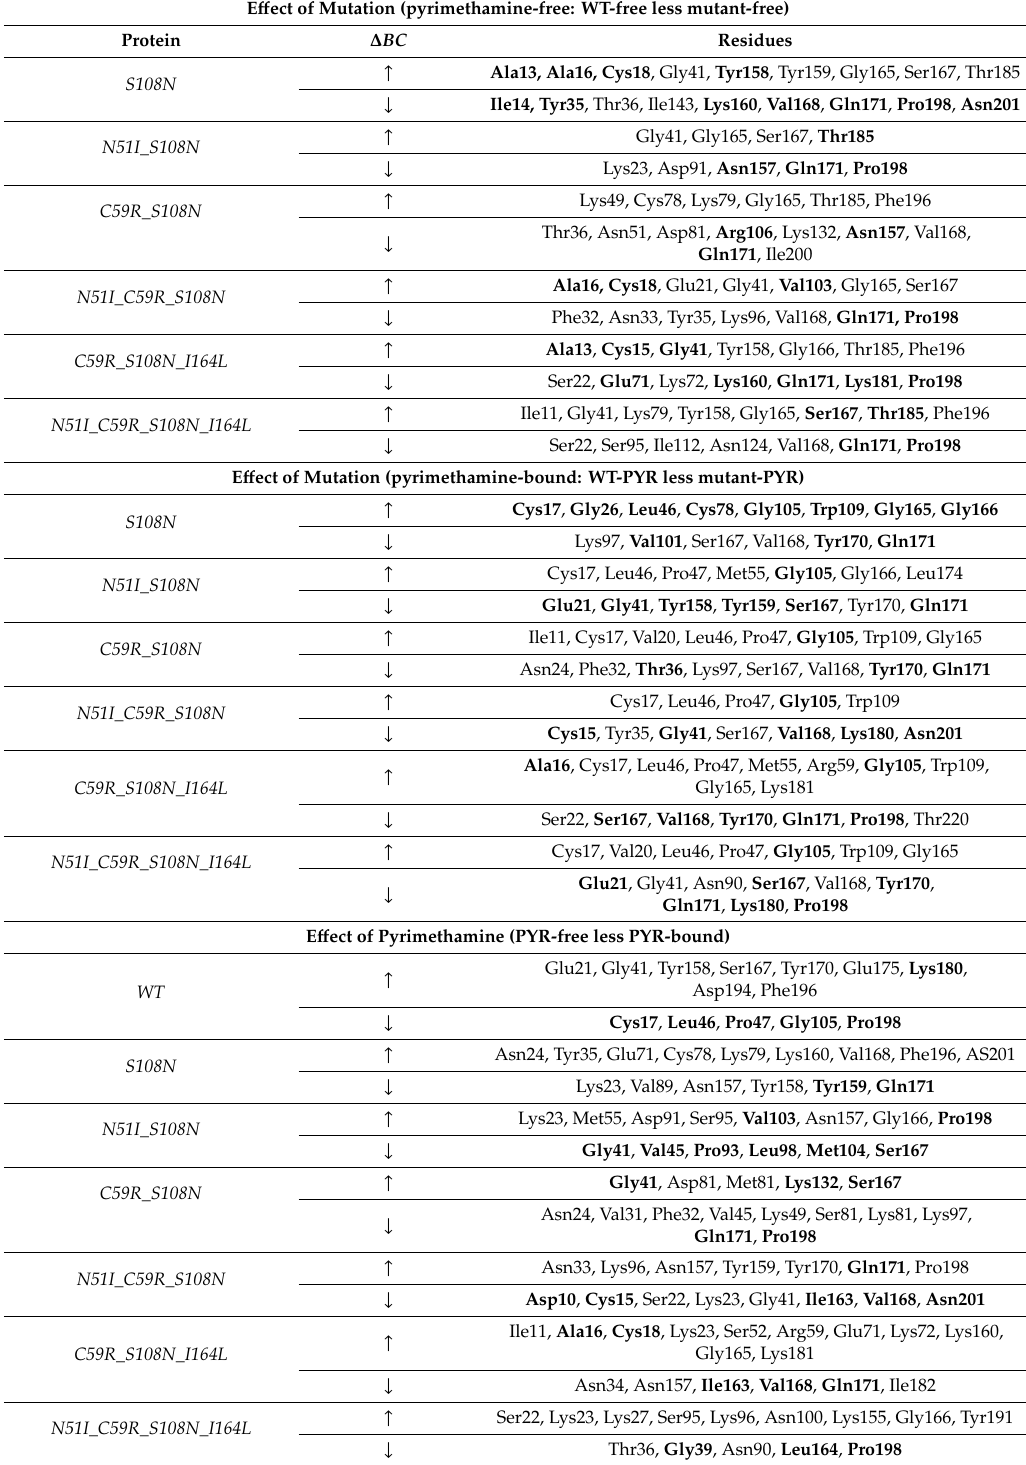
Table 2. Changes in betweenness centrality (BC) : Table of residues showing significant changes in average BC ( ∆ BC ) due to mutation (pyrimethamine-free: WT-free less mutant-free; pyrimethamine-bound: WT-PYR less mutant-PYR) and pyrimethamine binding (PYR-free less PYR-bound). In bold are residues showing changes in BC at sites with high centrality, while ↑ and ↓ signify residues with significant positive and negative ∆ BC values, respectively, obtained by using a threshold value of +/ − 2 SD of the ∆ BC values for each system. Positive ∆ BC signify decrease in residue connectivity while negative ∆ BC stands for increased residue connectivity and hence increased residue participation in